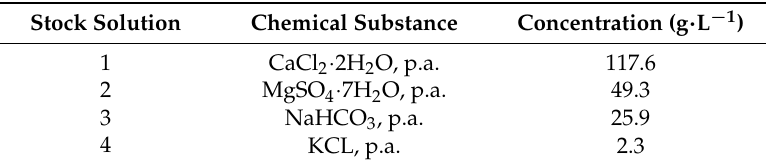
Table 3. Stock solution for the preparation of reconstituted